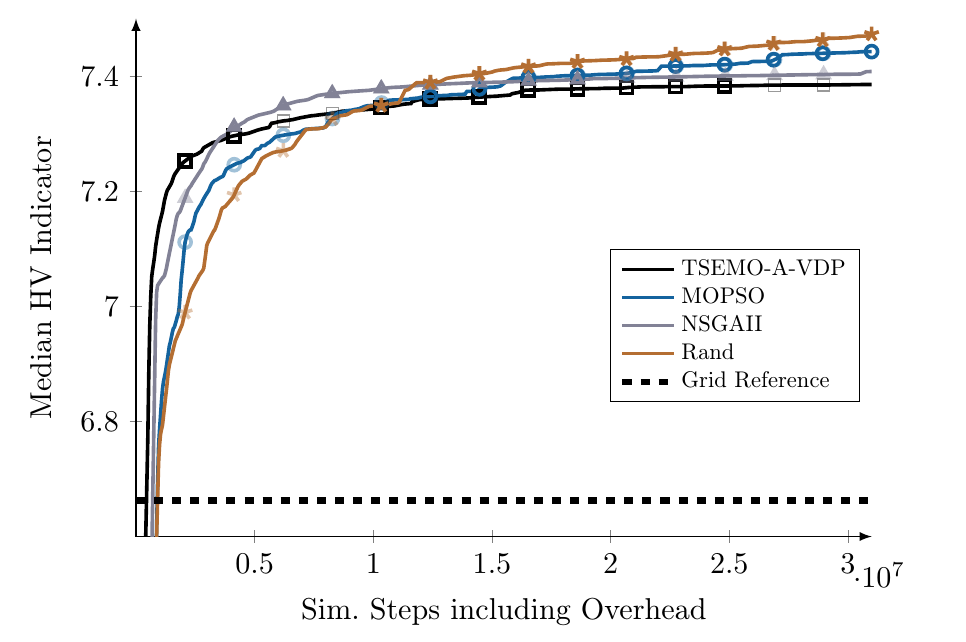
Figure 6. HV indicator as a function of simulation steps, including algorithmic overhead. Markers in light colors indicate that the HV indicator of the respective algorithm is statistically significantly worse than the best-performing optimizer.